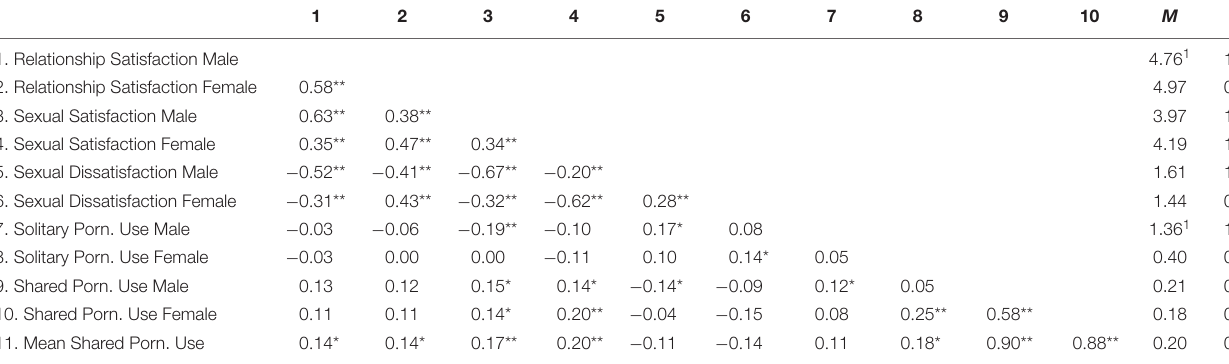
TABLE 8 | Summary of the correlations, means, and standard deviations of the focal variables for Study 4 ( N = 277 couples). 1 2 3